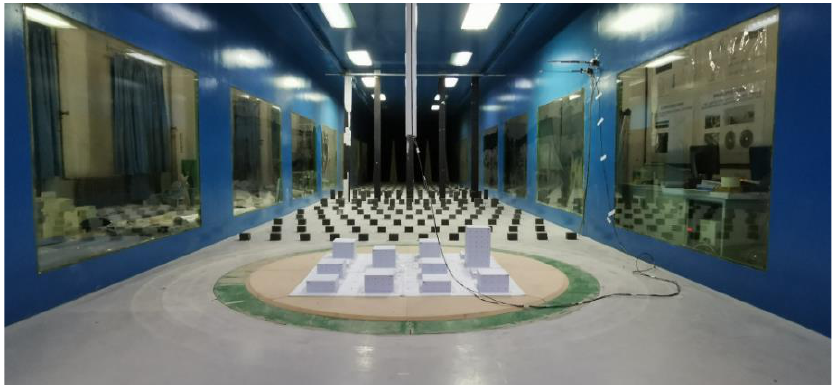
Figure 5. Wind tunnel test site layout.